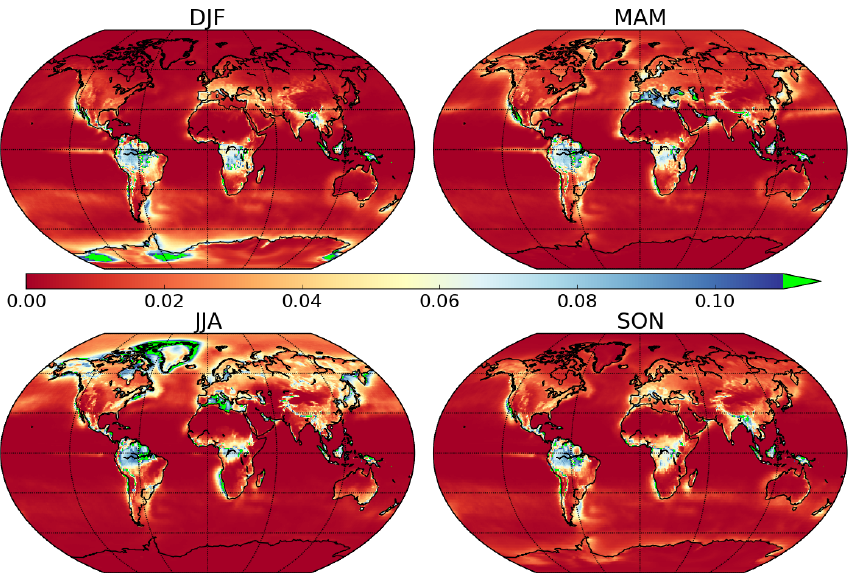
Figure 10. The absolute increase in the mean seasonal formation of dew (mmd − 1 ), when the emissivity of the condenser is increased from 0.94 to 0.999, and the albedo from 0.84 to 0.999.